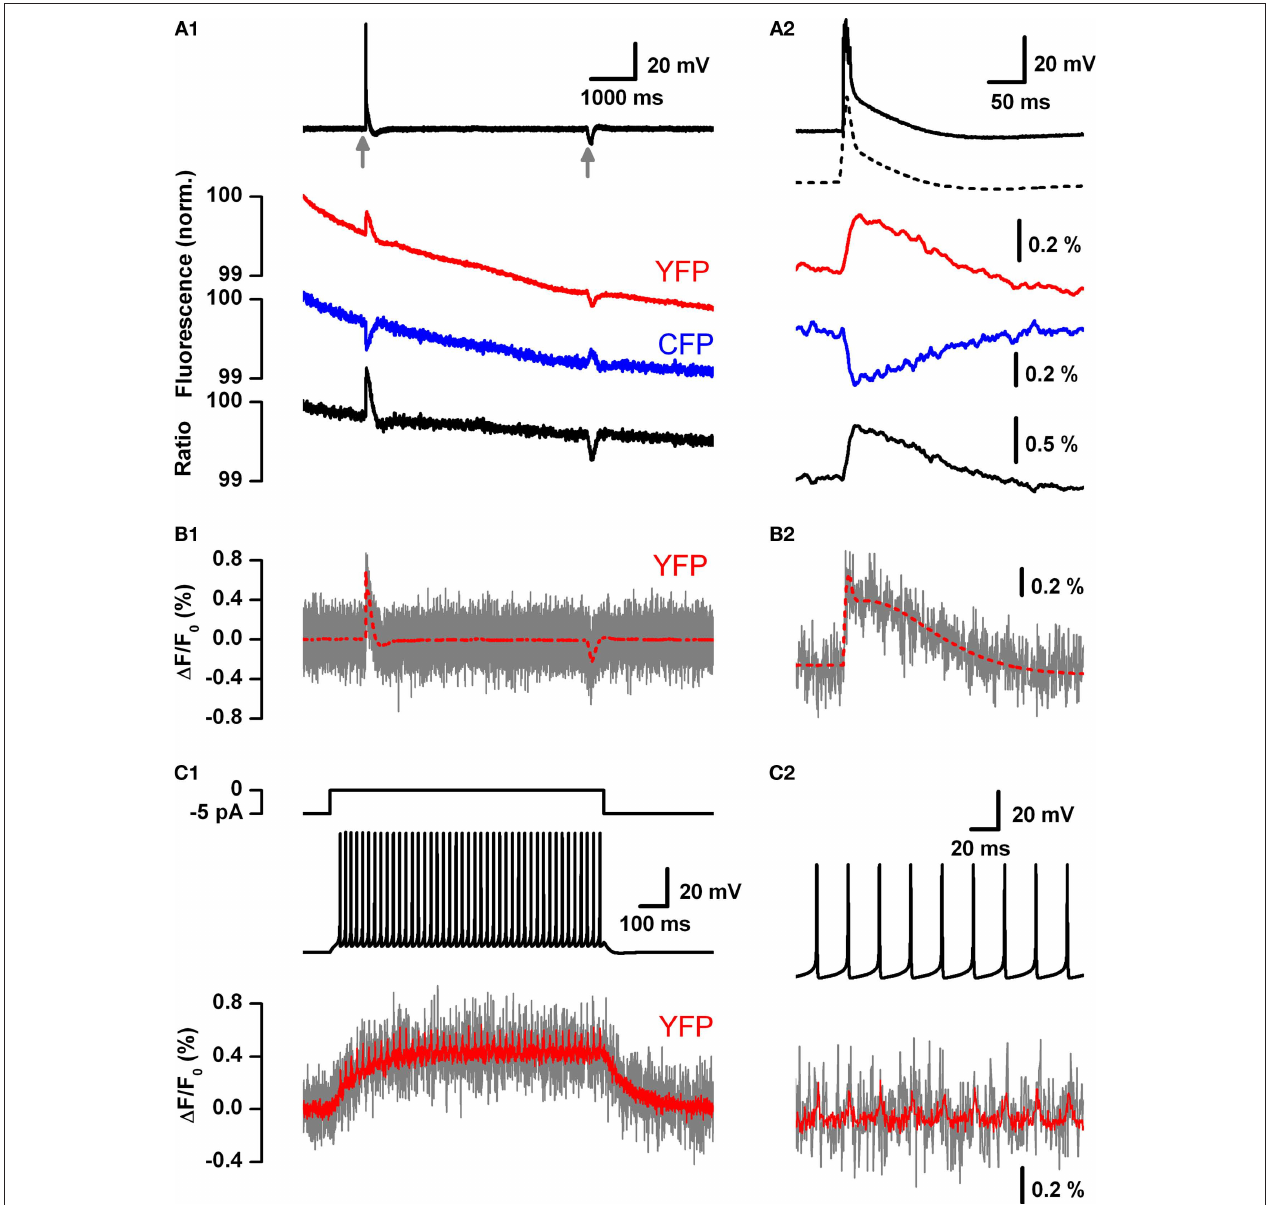
FIGURE 5| Estimation of the theoretical readout of simple and complex spikes from Purkinje neurons by voltage imaging using present generation VSFPs. (A1) A PC12 cell expressing VSFP2.1 was voltage-clamped with a voltage trace (top black trace) from a cerebellar Purkinje neuron during induction of a climbing fi ber response (complex spike; marked by arrow) and during intracellular injection of a small hyperpolarizing current pulse (marked by a second arrow). Traces show membrane potential (top trace), yellow fl uorescence (YFP; red trace), cyan fl uorescence (CFP; blue trace) and the ratio of yellow and cyan fl uorescence (bottom black trace). The voltage trace was recorded with 1 kHz cutoff frequency. Fluorescence signals were digitally low pass fi ltered (0.1 kHz), averaged over 20 consecutive sweeps and scaled in units of normalized absolute fl uorescence. (Mutoh and Knöpfel, unpublished data, Methods as in Dimitrov et al., 2007). (A2) Same traces as in (A1) at expanded time scale. The black dotted trace is the low pass-fi ltered complex spike obtained from the upper voltage trace (black continuous line) by digital fi ltering with 0.1 kHz cutoff. The fl uorescence traces are represented in units of the differential fl uorescence